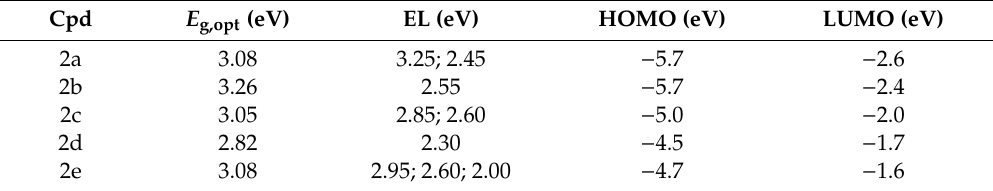
Table 4. Comparison of optical energy gaps and electroluminescence peaks, together with the energy of frontier orbitals. EL, electroluminescence.